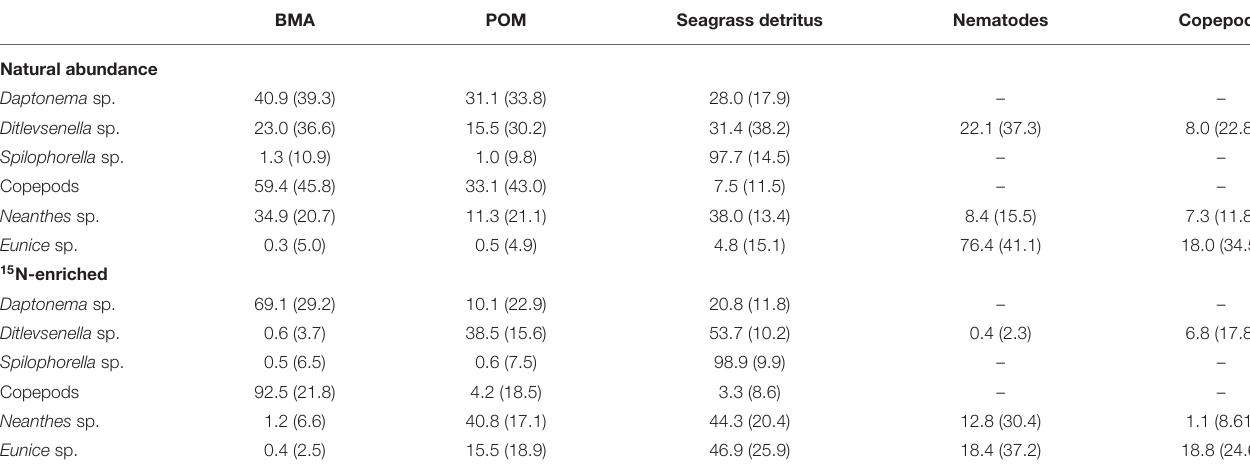
TABLE 3 | Mixing model results from natural abundance stable isotopes (data from Xu et al., 2018) and isotope tracer addition data for mean percentage (SD) of food sources in the diet of animals (– = food source was not included). BMA POM Seagrass detritus Nematodes Copepods Natural abundance Daptonema sp. Ditlevsenella